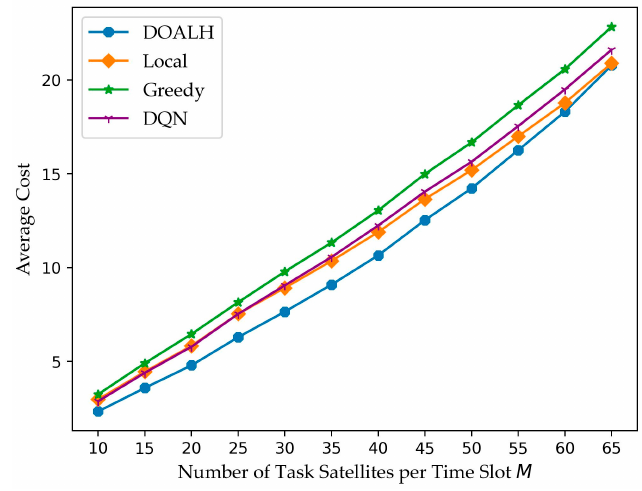
Figure 6. 𝑉 = 10, 𝛽 = 0.1, 𝐵 = 500 (Mb/s) Average 𝐶𝑜𝑠𝑡 vs. 𝑀 .